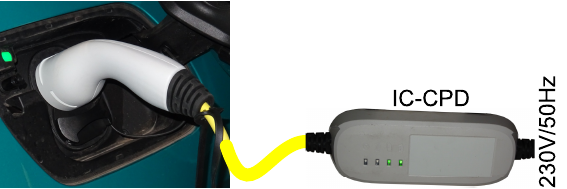
Figure 2. The photo of the connector in electric vehicle (during charging) and the charging current controller